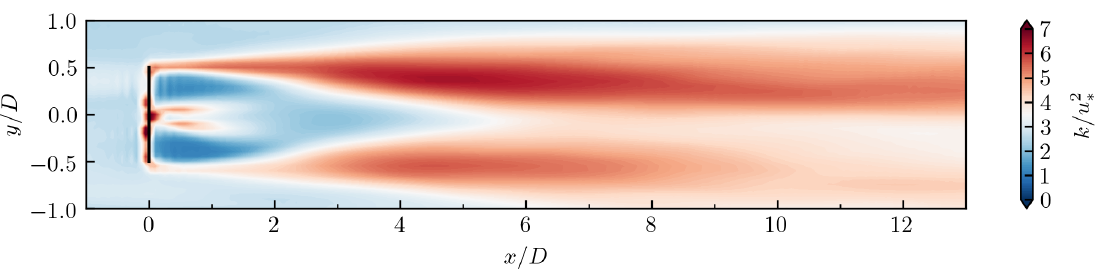
Figure 17. The averaged vertical vorticity in the horizontal plane at the hub height. The positive and negative peaks of the vorticity are marked with the dashed lines.